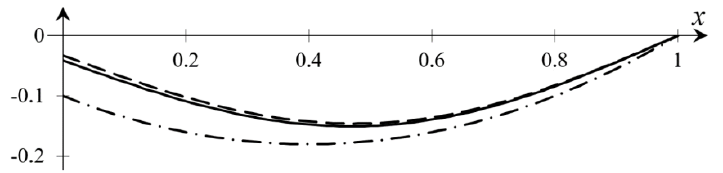
Figure 3. Graphs of 𝑄 1 (𝑥, 0) (solid line), 𝑄 2 (𝑥, 0) (dashed line) and 𝜑 0 (𝑥) (dash-dotted line). The graphs of the functions 𝑄 1 (𝑥, 3) , 𝑄 2 (𝑥, 3) and 𝜑 1 (𝑥) are shown in Figure 4, which illustrates the small discrepancies between these functions.